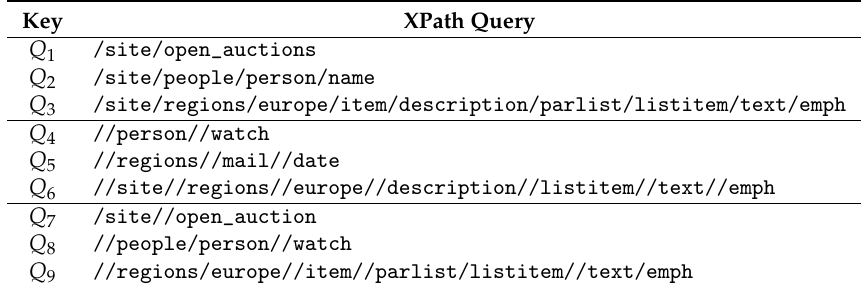
Table 2. Set of queries for XMark